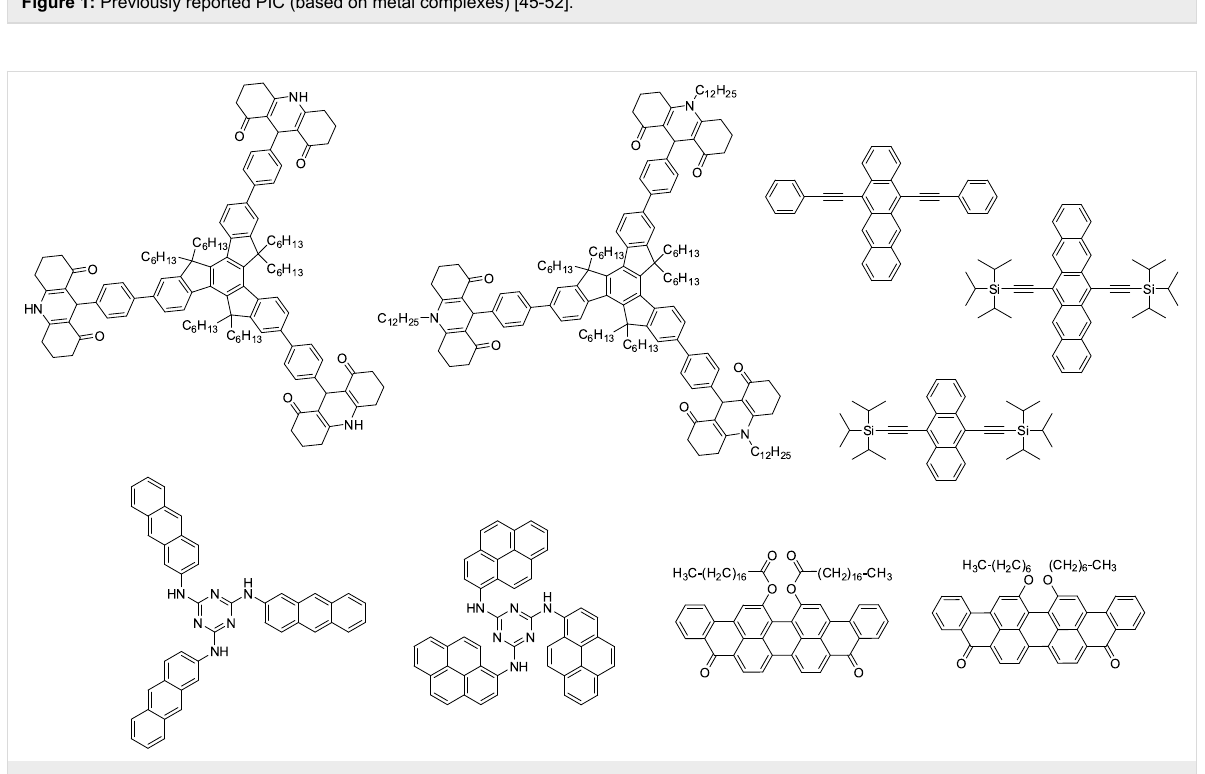
Figure 2: Previously reported PIC (metal free organic molecules) [54,55].